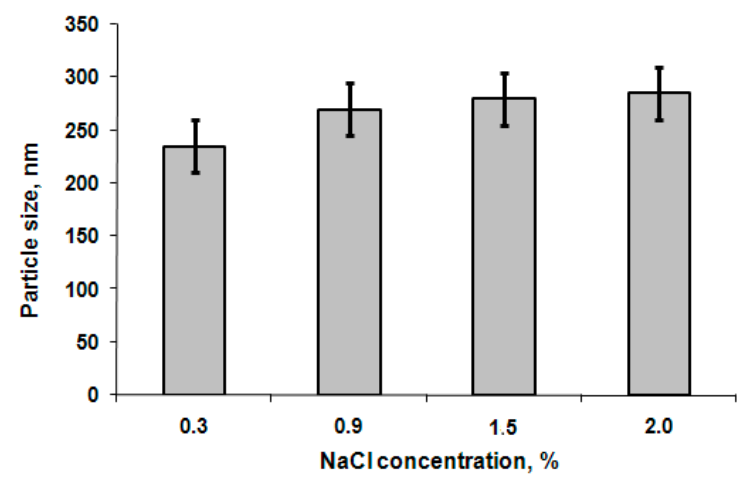
Figure 5. Effect of salt concentration on mean size of nanoparticles (polymer sample GP3, pH 7.4, particle concentration 0.5 mg/mL).